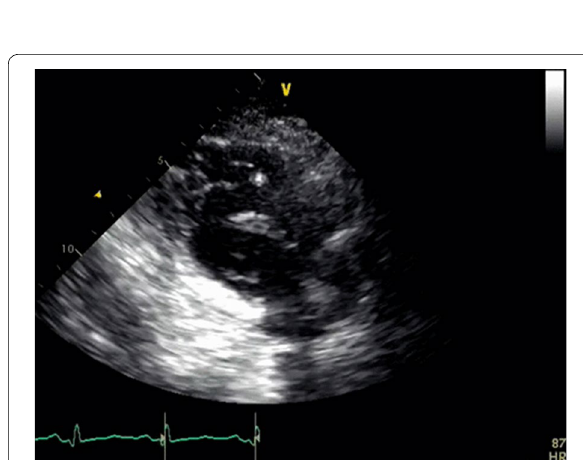
Fig. 2 Right ventricular inflow view with large mobile thrombus crossing into the right ventricle